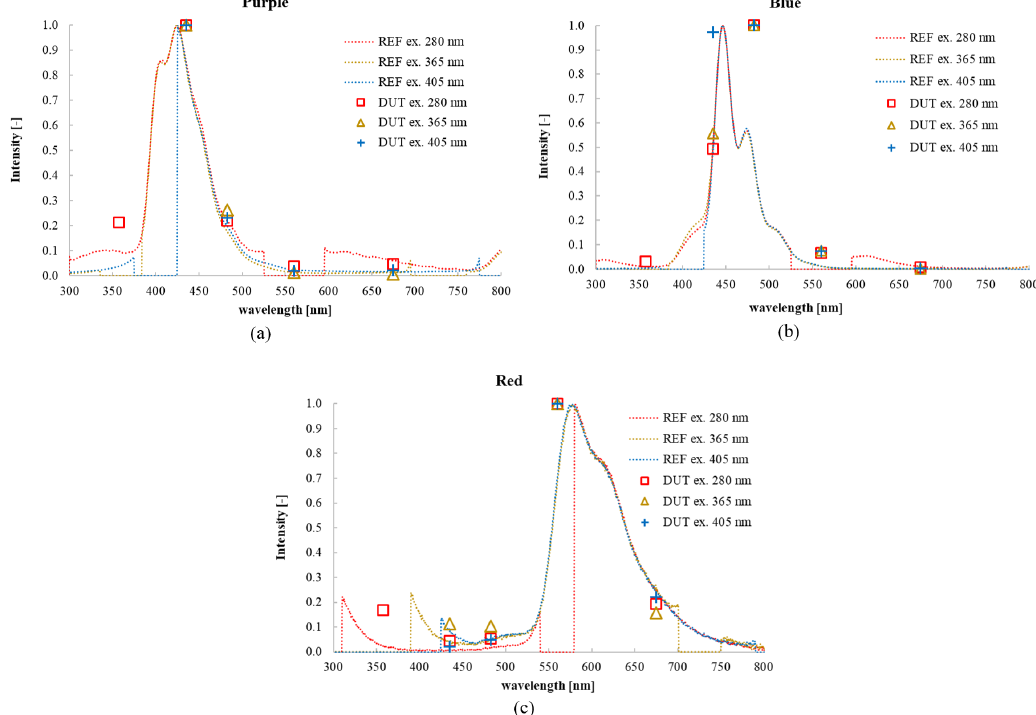
Figure 9. Comparison of the reference (REF) fluorescence measurements from Könemann et al. (2019) to the measurements with the Poleno instrument (DUT). All measurements are scaled to a maximum value of